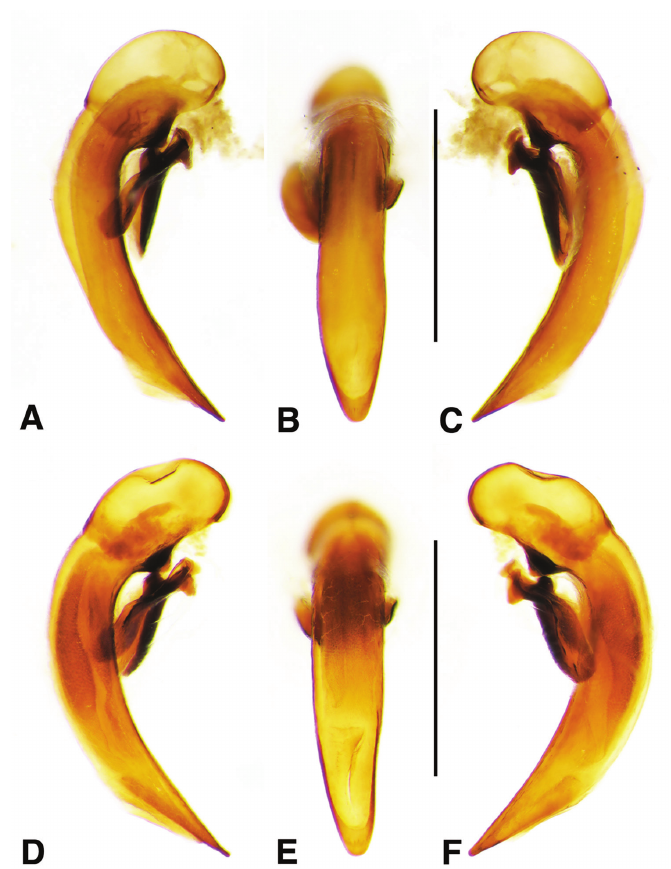
C, F left lateral aspect. A–C D. beauvoisii (Dejean) D–F D. cinctus (Putzeys). Scale bars 1